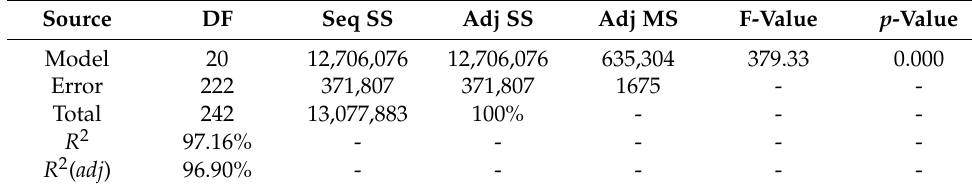
Table 3. ANOVA for Response Throughput.